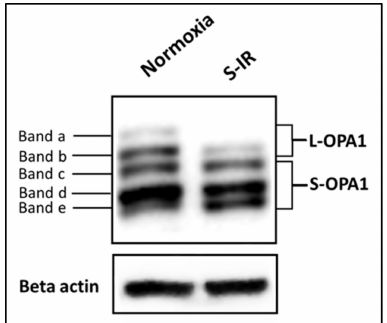
Figure 5. Example of OPA1 expression in whole cell lysates obtained from HL-1 cardiomyocytes under normoxic conditions and following simulated ischemia-reperfusion. HL-1 cardiomyocytes display five distinct OPA1 forms (bands a–e: 75–100 kDa), including two long (L) forms (bands a,b) and three short (S) forms (bands c–e). Ischemia-reperfusion is associated with the reduced expression of L-OPA1 bands due to OMA1-mediated cleavage of OPA1 and an attendant increase in expression of S-OPA1. S-IR = simulated